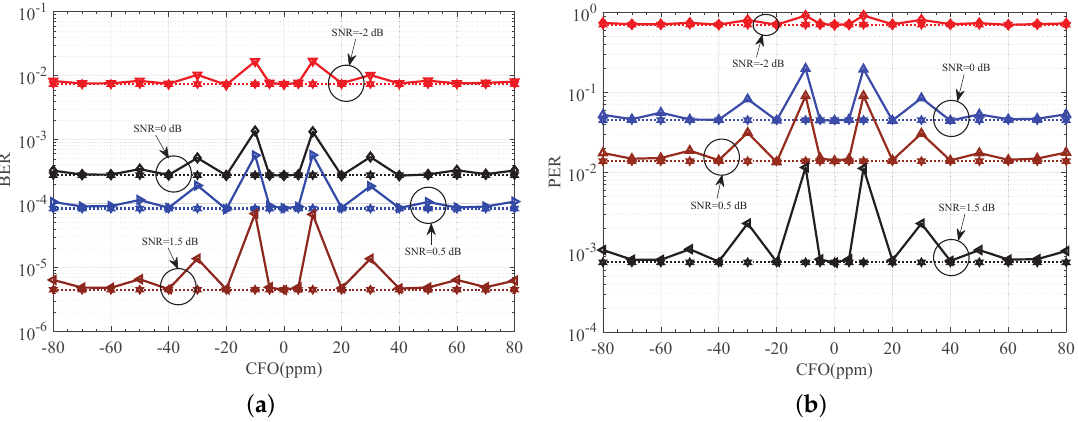
Figure 11. Detection performance of proposed receiver. ( a ) BER performance of proposed receiver versus CFO; ( b ) PER performance of proposed receiver versus CFO. CFO: carrier frequency